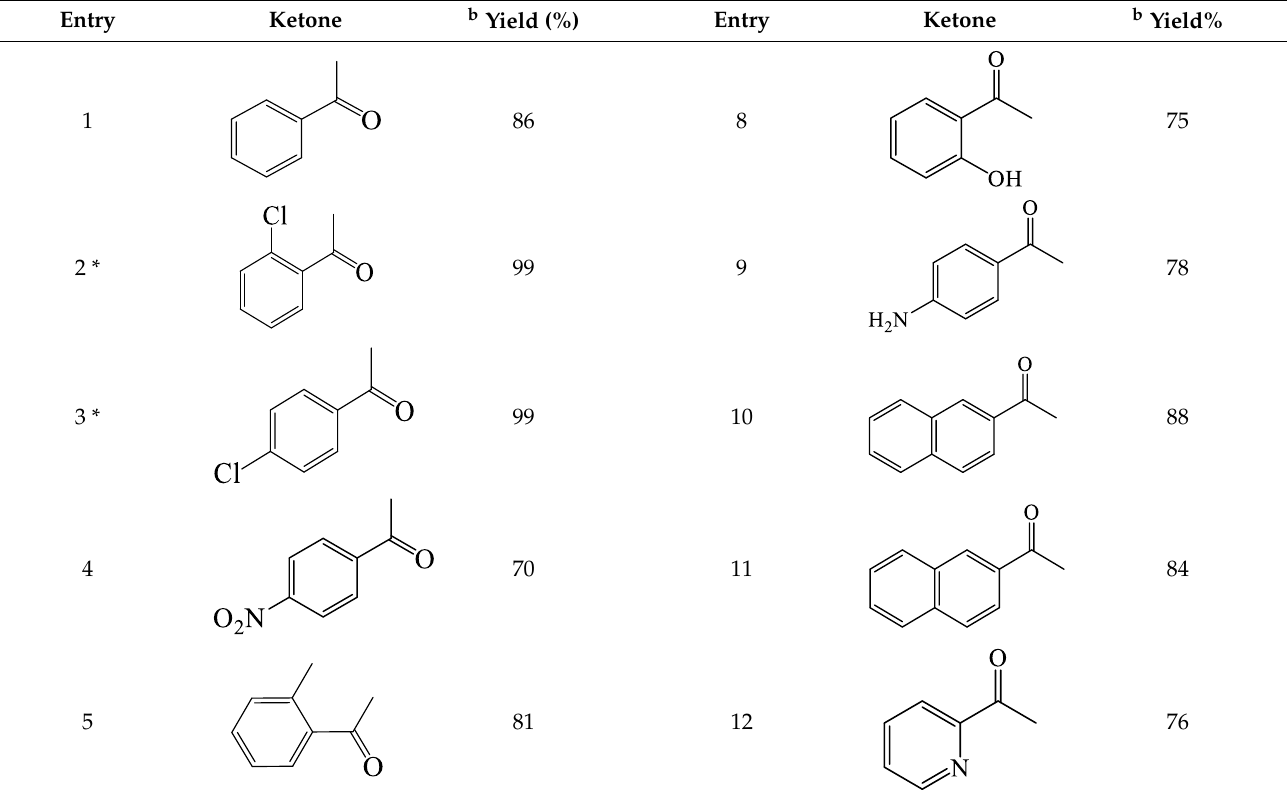
Table 4. Investigation of substrate scope using complex Ru2 as a catalyst a .